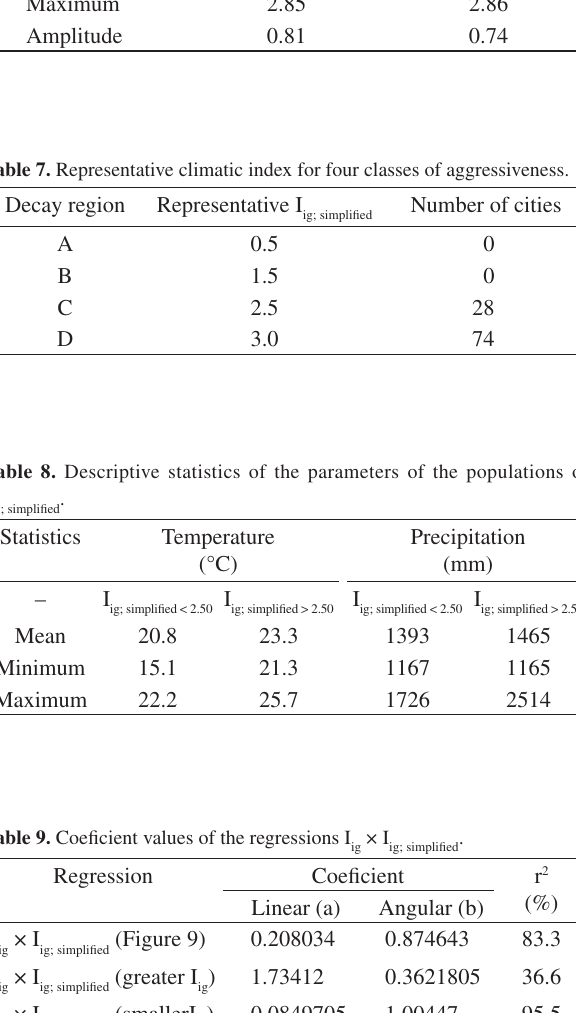
and I for the cities of the greatest ig ig; simplified